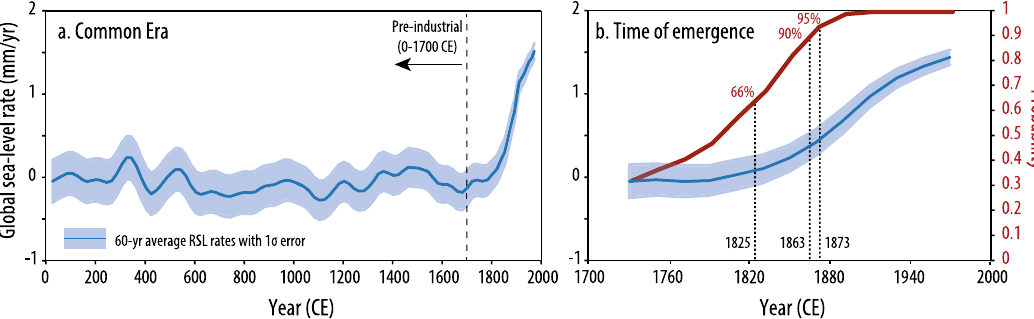
Fig. 1 Time of emergence of global sea-level rise. a Sixty-year average rates over the Common Era, where pre-industrial is 0 – 1700 CE. b Sixty-year average rates from 1700 to 2000 CE which increase concurrently with the probability that each 60-year interval and all subsequent 60-year intervals were greater than a random 60-year interval during the pre-industrial Common Era. The time of emergence year is given for 0.66, 0.90, and 0.95 probabilities. Model predictions are the mean with 1 σ